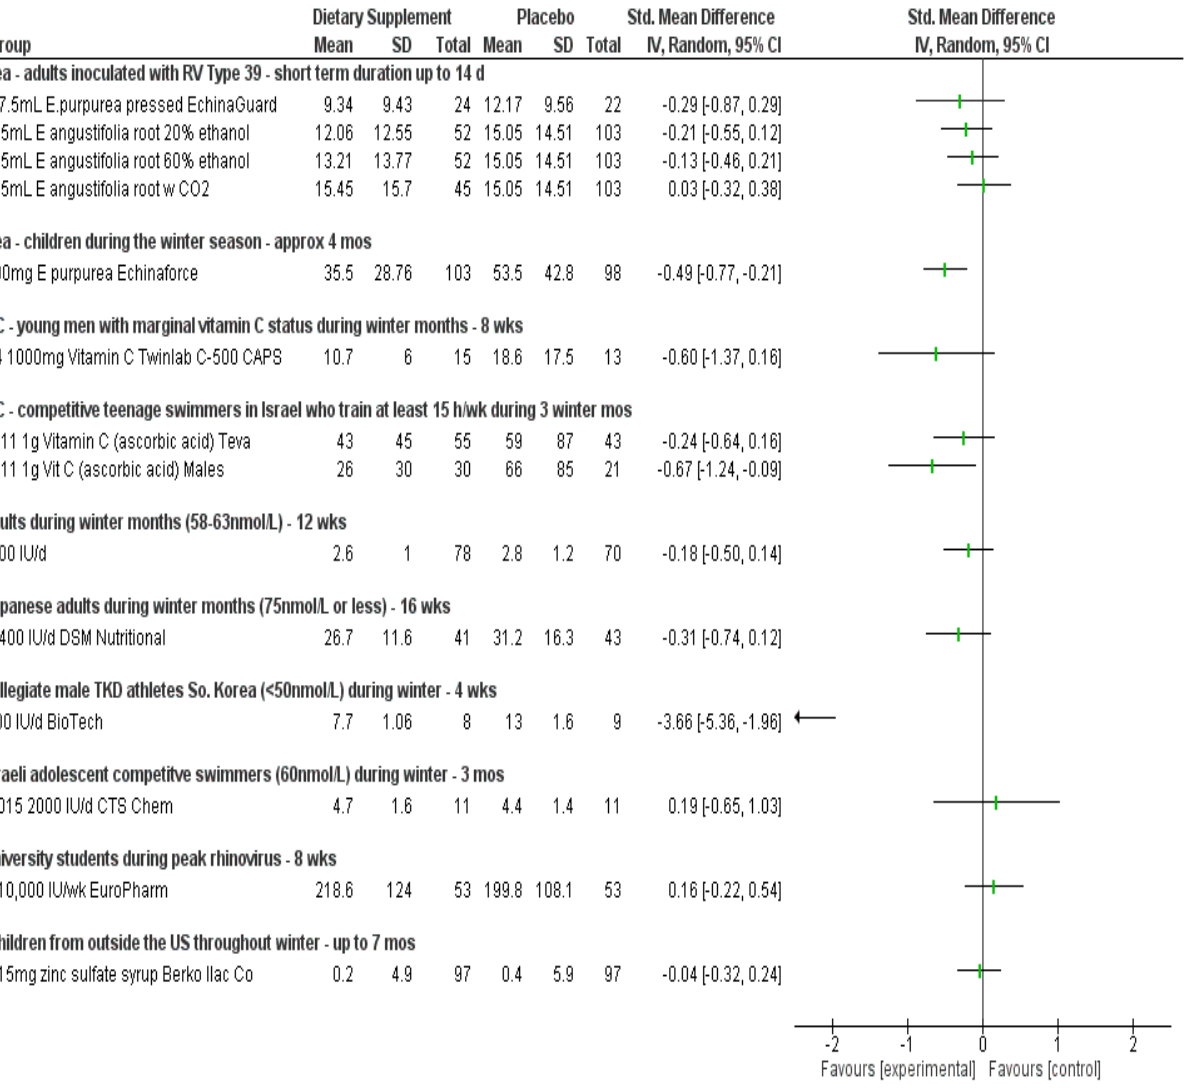
Figure 2. Analysis 1.2 Severity of symptoms as reported by participants.